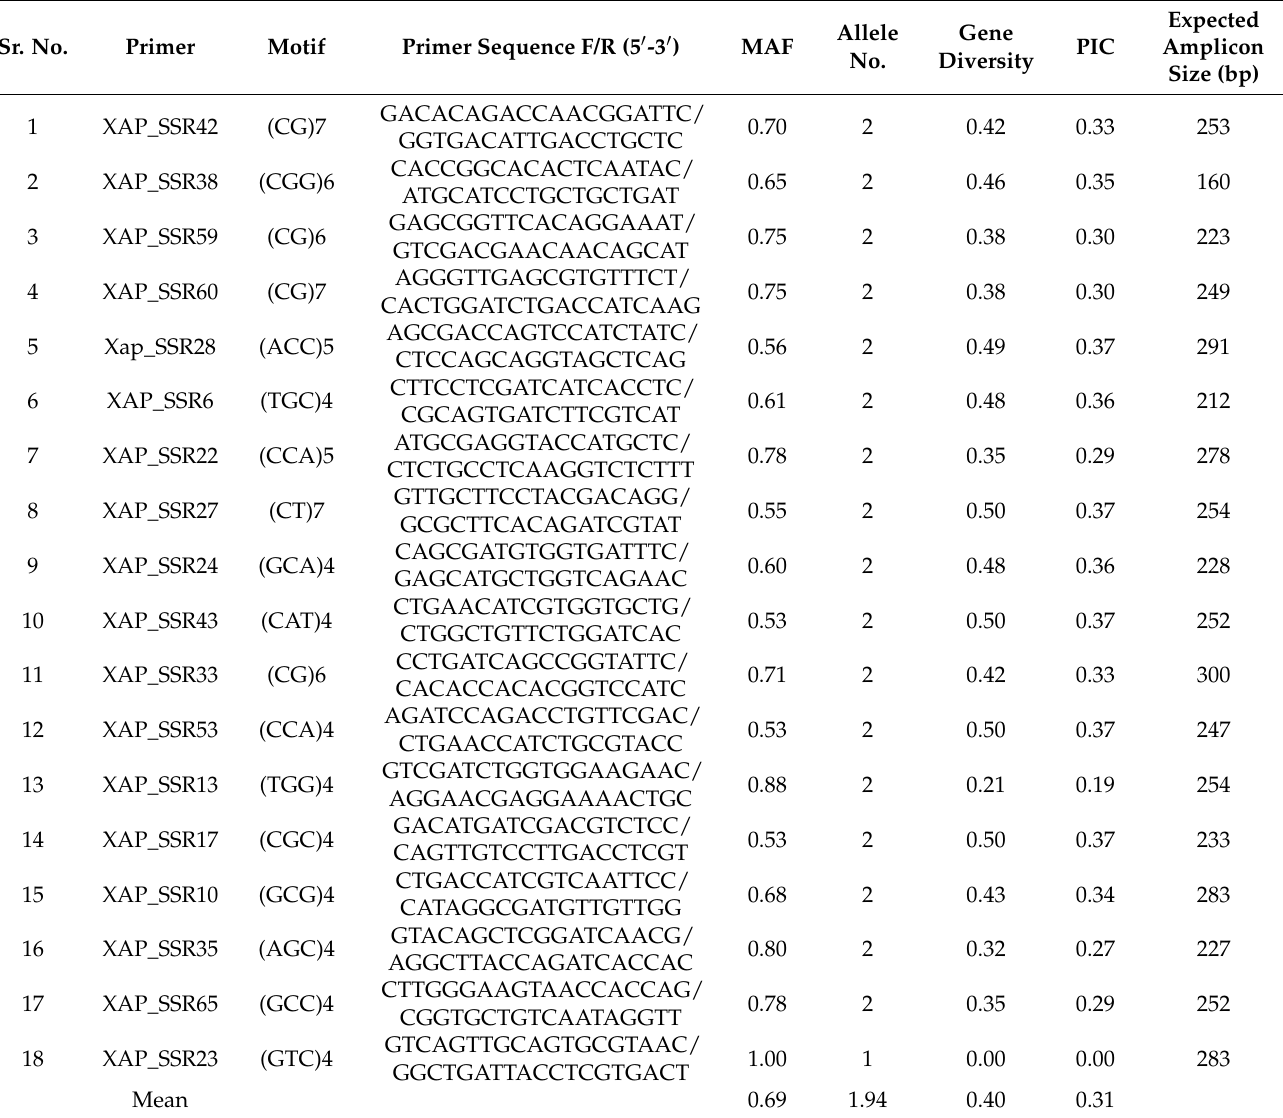
Table 3. Details of 18 XAP-SSR primers used for the genetic diversity